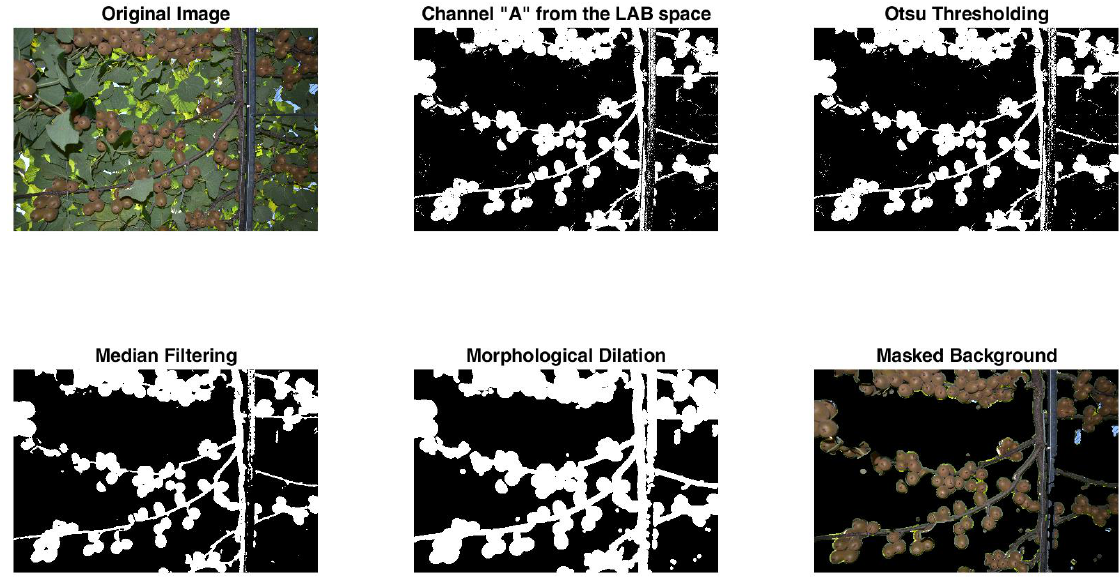
Figure 8. Image preprocessing example.